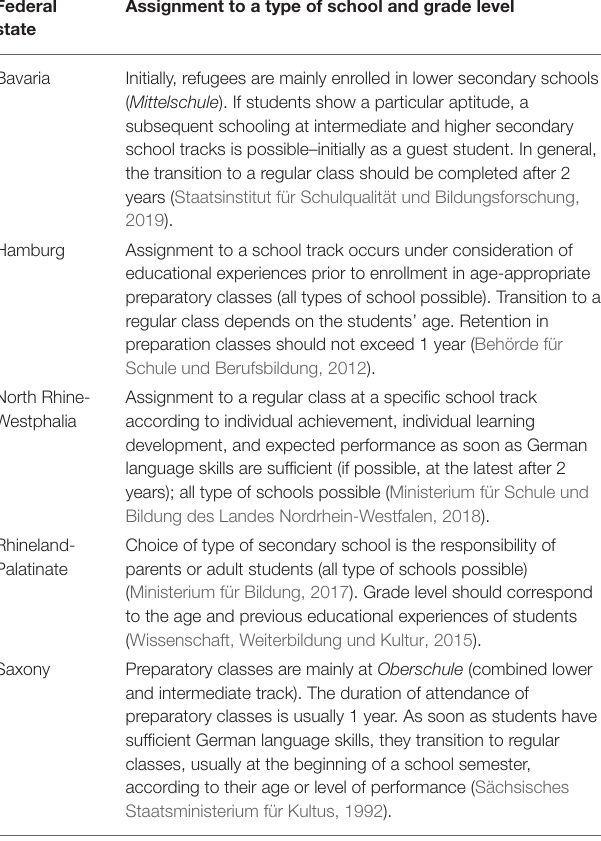
TABLE 3 | Assignment to type of school and grade